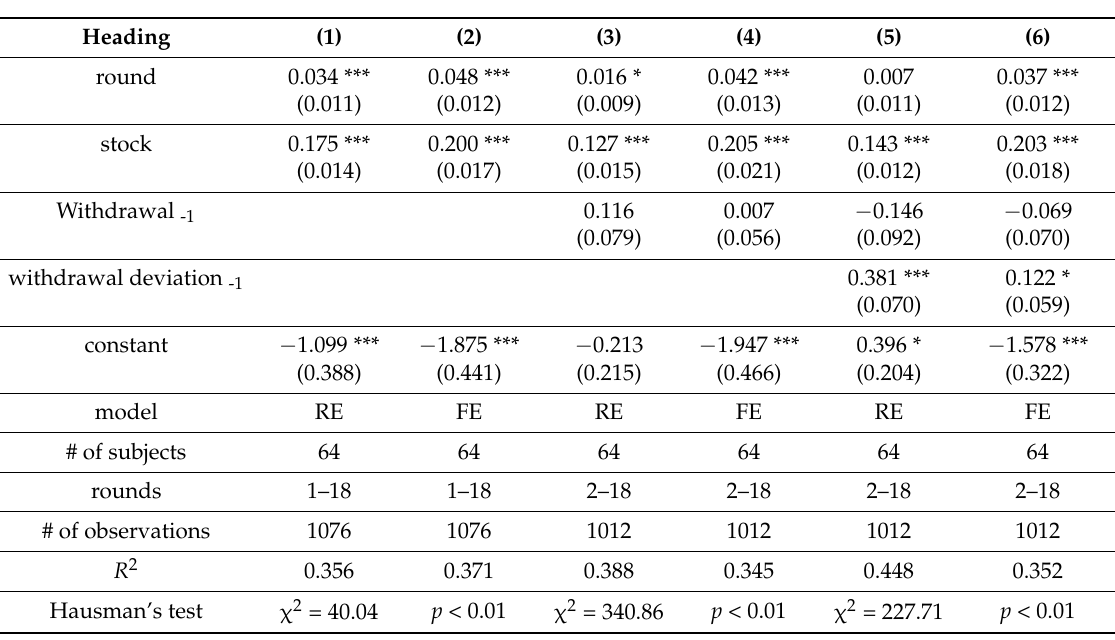
Table A1. Regressions of